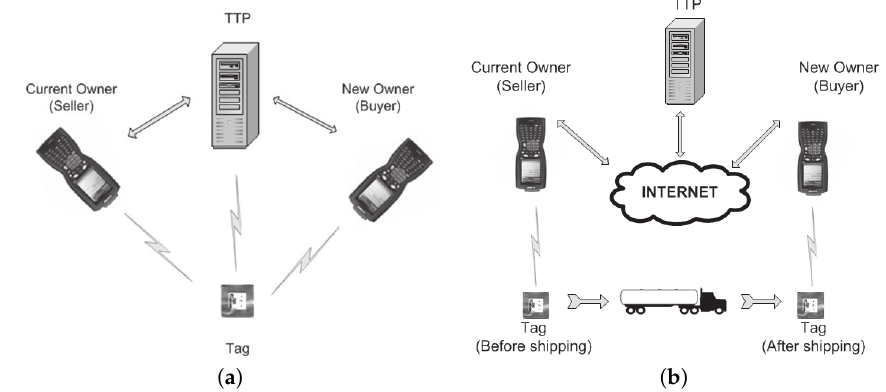
Figure 2. OTP communication models. ( a ) Basic model (static); ( b ) Dynamic model.